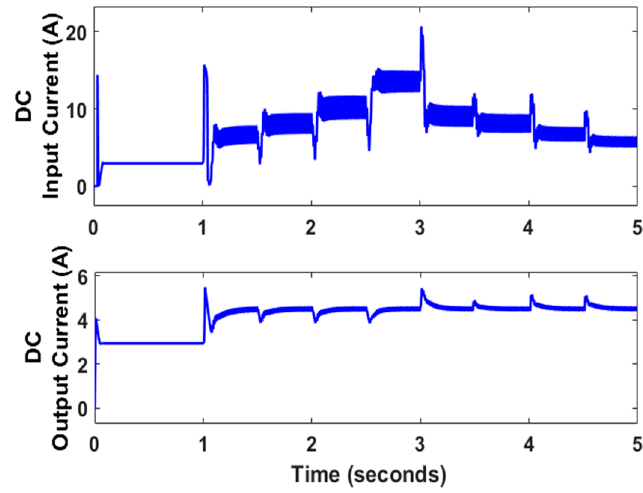
Figure 7. Input current and output current of the boost converter.